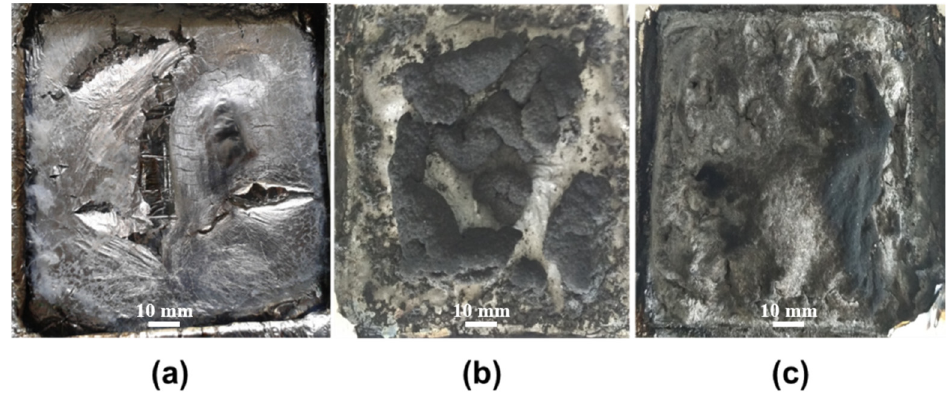
Figure 3. Digital photographs of PLA and PLA composites after CONE test from a vertical perspec- tive: neat PLA ( a ), A1C1M0 ( b ), and A2C1M1 ( c ).